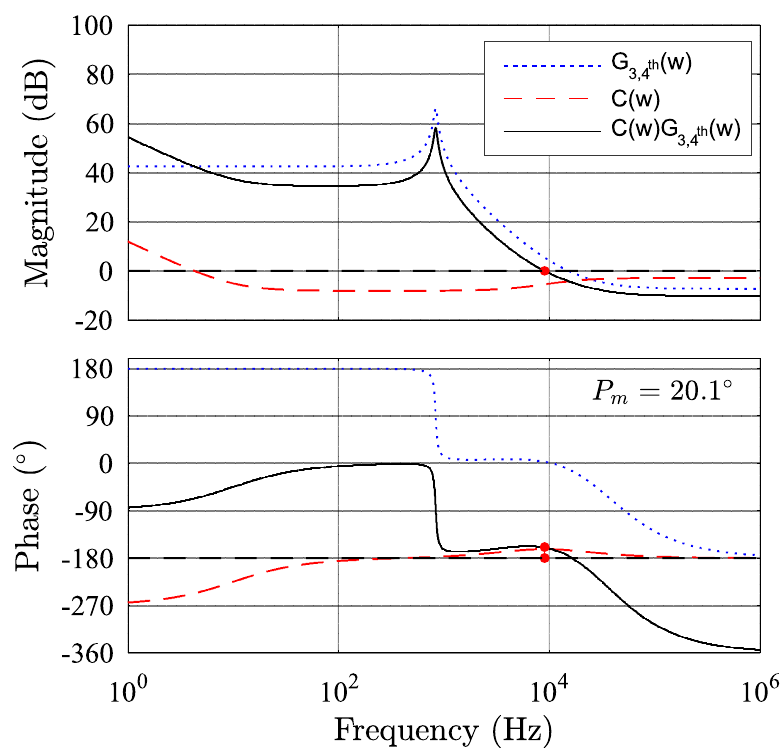
Figure 6. Controller design Bode diagram in the w